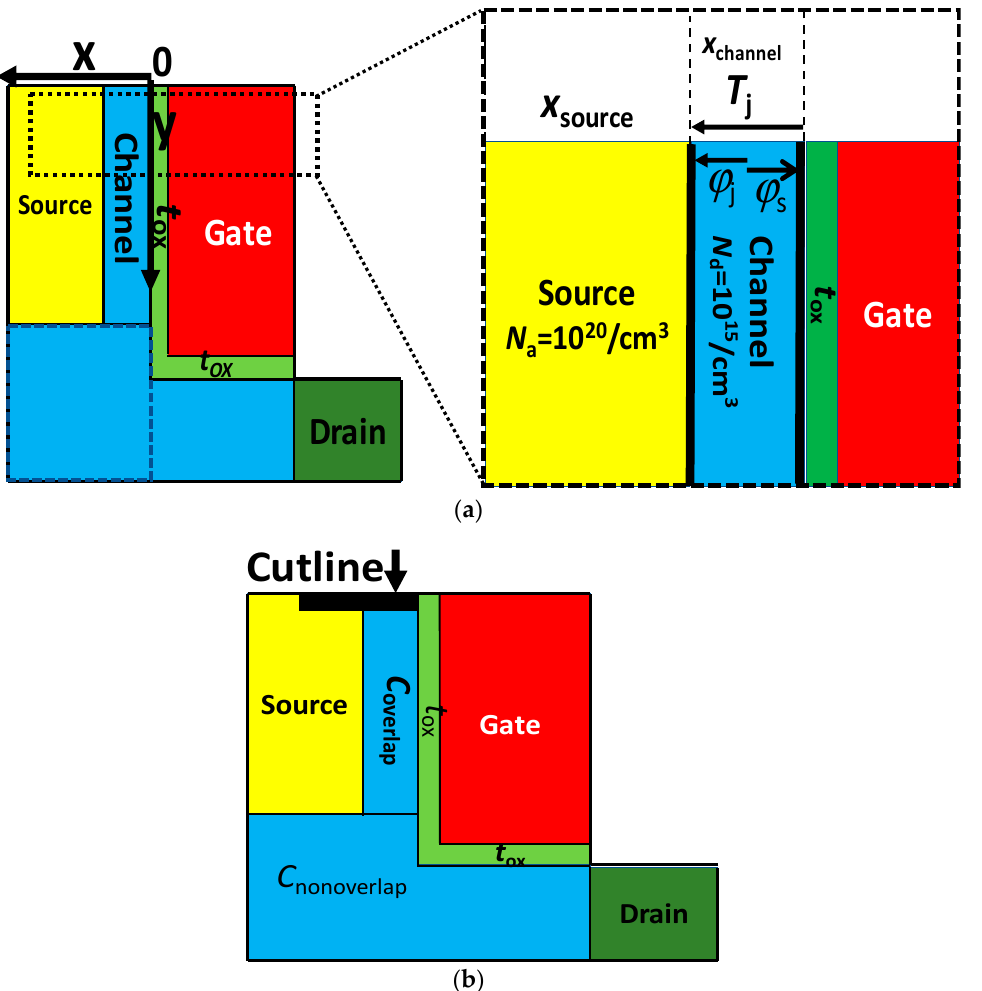
Figure 4. ( a ) Magnified part of C overlap and source regions of the LTFET to illustrate parameters used in the 1D model. Device origin is at the dielectric/channel interface. x and y are in the horizontal and vertical directions, respectively. ( b ) Only a single y -point is considered in the 1D model, illustrated by the cutline. Figures 5d–f and 6a,b to follow are along the same cutline with x = 0 nm at the channel–dielectric interface.